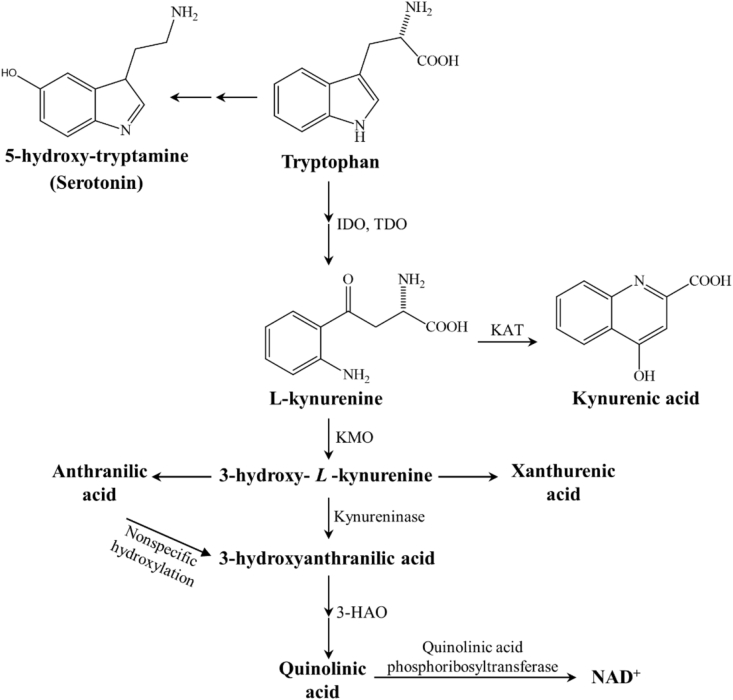
The kynurenine metabolite pathway. 3-HAO 3-hydroxyanthranilate oxidase, IDO/TDO indoleamine 2,3-dioxygenase/tryptophan 2,3-dioxygenase, KAT kynurenine aminotransferase, KMO kynurenine 3-monooxygenase, NAD+ nicotineamide adenine dinucleotide.